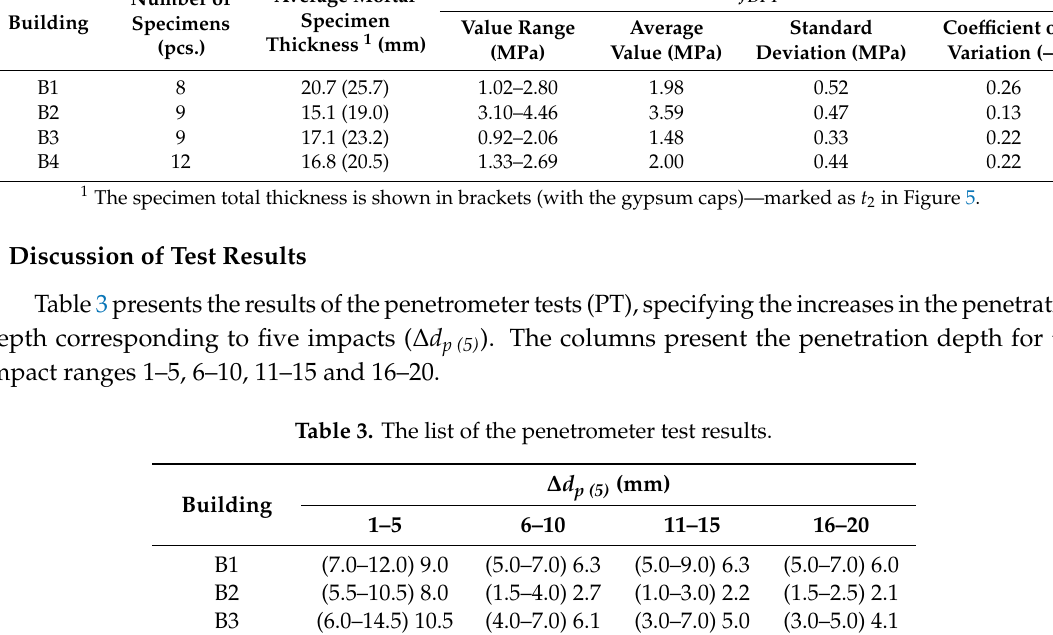
In brackets—the range values. Outside the brackets—the average